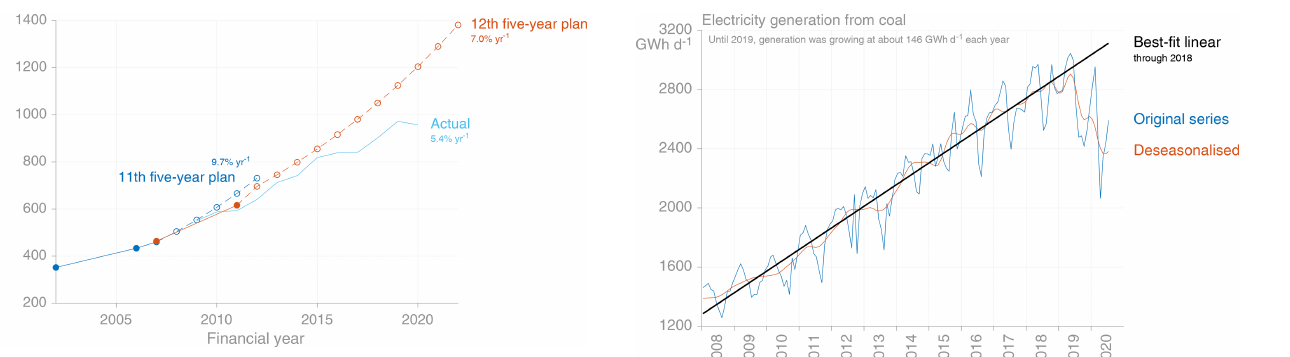
Figure 5. Average daily electricity generation from coal by month, divided by month length and deseasonalised, with a best-fit linear regression. Source: Central Electricity Authority, own